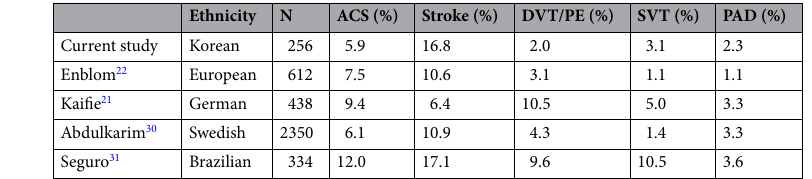
Table 4. Comparison of thrombosis site. MPN, myeloproliferative neoplasms; PV, polycythemia vera; ET, essential thrombocythemia; PMF, primary myelofibrosis; ACS, acute coronary disease; DVT, deep vein thrombosis; PE, pulmonary embolism; SVT, splanchnic vein thrombosis; PAD, peripheral artery disease.